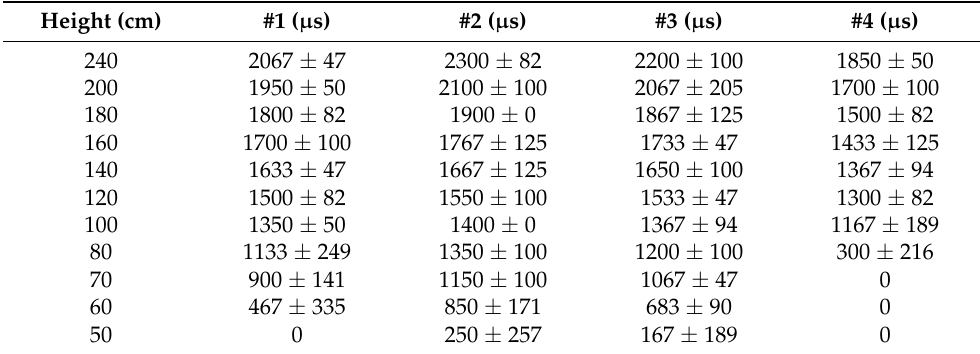
Figure 4. The images of the energy release process of the #1 material at a drop height of 240 cm. Three experiments were performed under the same drop height to calculate the average flame duration. Table 5 records the average and standard deviation of the flame duration of the four specimens at different drop heights. Table 5. The average and standard deviation of flame duration at different drop